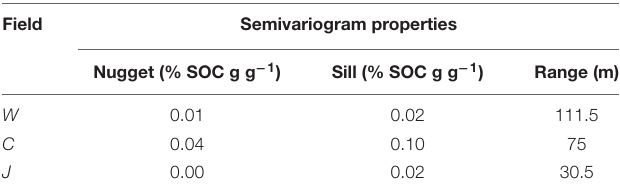
TABLE 2 | Properties of the fitted semivariograms of the sampled fields, spherical model.